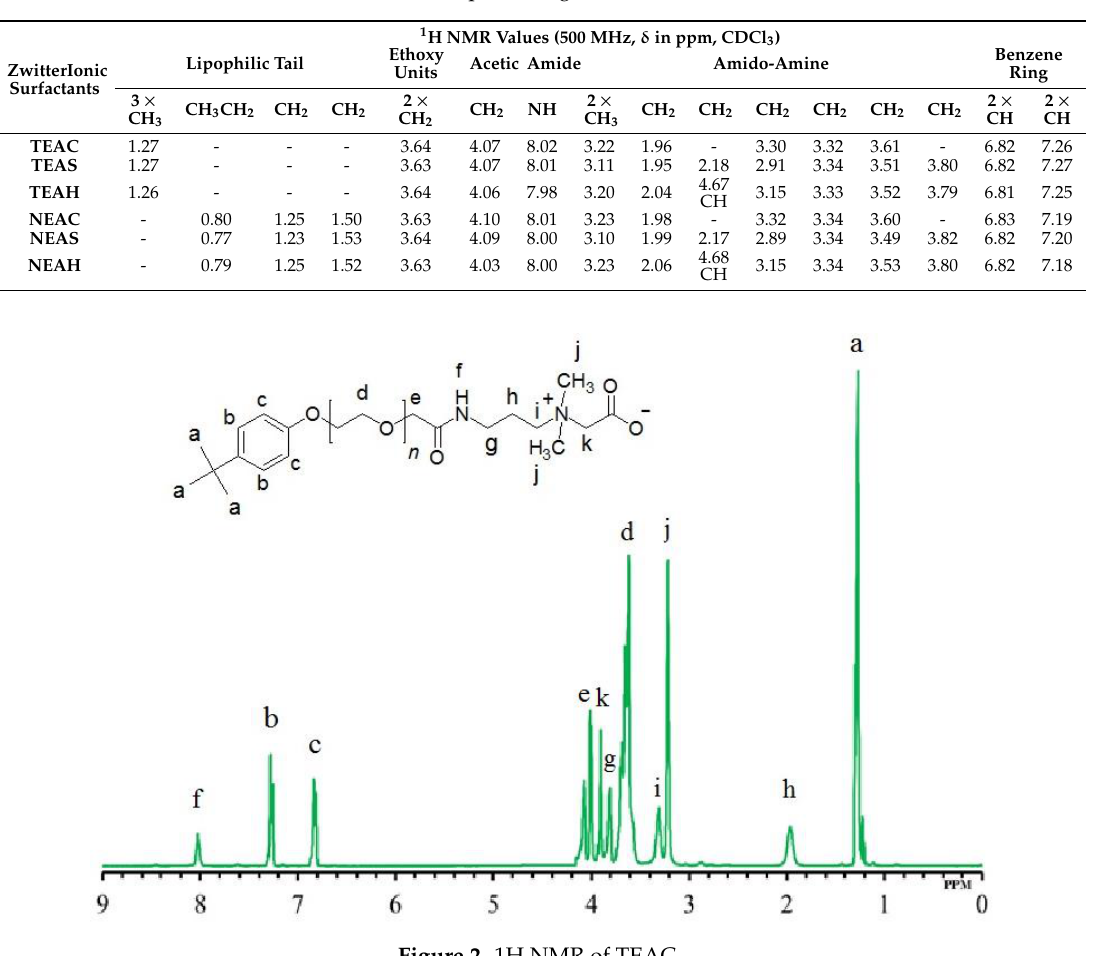
Table 1. 1 H NMR values and peak assignment of zwitterionic surfactants.